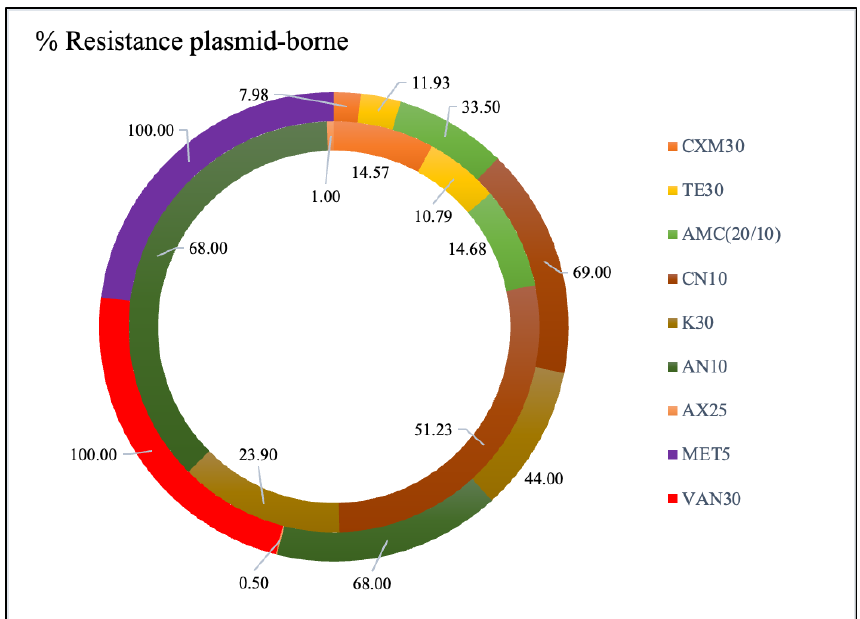
Figure 5. Plasmid-borne antibiotic profile of MDR isolates from fruits (outer circle) and juices (inner circle). Legend: K30: kanamycin 30 ( μ g); CN10: gentamycin 10 ( μ g); AN10: ampicillin 10 ( μ g); AX25: amoxicillin 25 ( μ g); TE30: tetracycline 30 ( μ g); CXM: cefuroxime 30 ( μ g); VAN30: vancomycin 30 ( μ g); MET5: methicillin 5 ( μ g); AMC: amoxicillin: clavulanic acid (20/10 μ g).